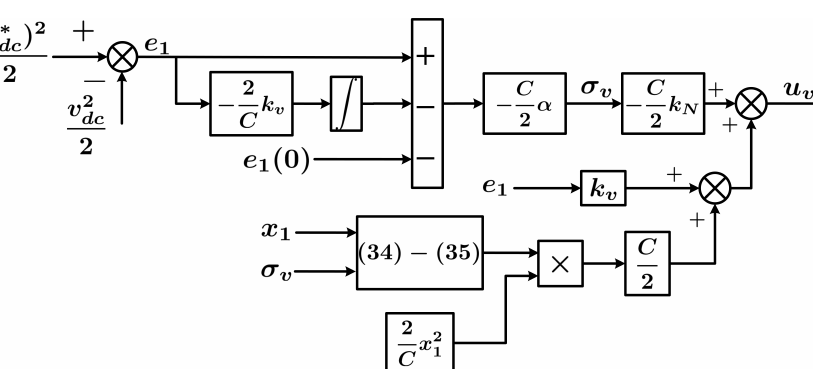
Figure 5. Control structure of voltage regulation